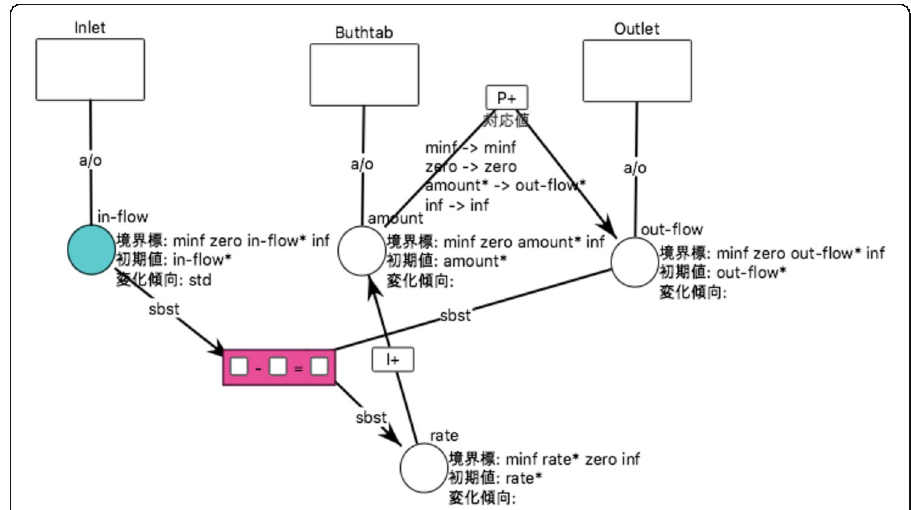
Fig. 1 Model of the change of amount of water in a bathtub. This is a model built with Evans that represents the change of the amount of water in a bathtub, in which constant amount enters from an inlet (in-flow) and the amount proportional to the water level exits from an outlet (out-flow). Objects “ bathtub, ” “ inlet, ” and “ outlet ” have the attributes “ amount, ” “ in-flow, ” and “ out-flow ” respectively. In-flow is constant and outlet is proportional to the water level (amount). The parameter “ rate ” is defined as the subtraction of outlet from inlet that is integrated to be the amount of water. The model is translated into a set of qualitative equations, and its temporal behavior is